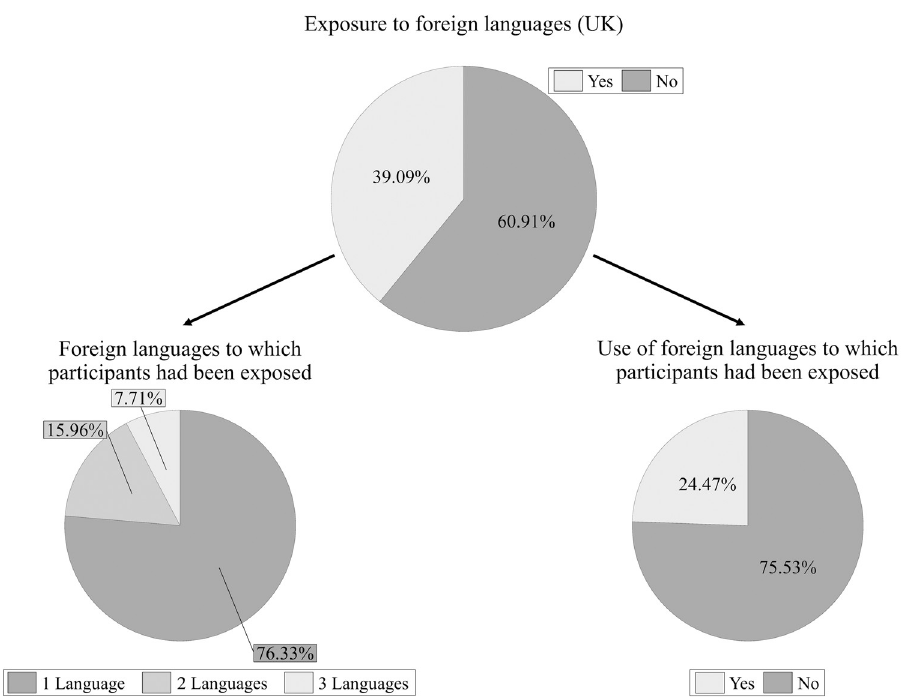
Fig 2. Relative frequency of foreign language exposure in the UK. The pie chart above represents the proportion of participants who reported having been exposed (n = 376) or not exposed (n = 586) to foreign languages in the UK. Out of the total number of participants who had been exposed to foreign languages, the lower-left pie chart shows the proportion of participants who had been exposed to one (n = 287), two (n = 60), or three (n = 29) foreign languages; the lower-right pie chart shows the proportion of participants who reported the use (n = 92) or no use (n = 284) of the foreign languages to which they had been exposed.